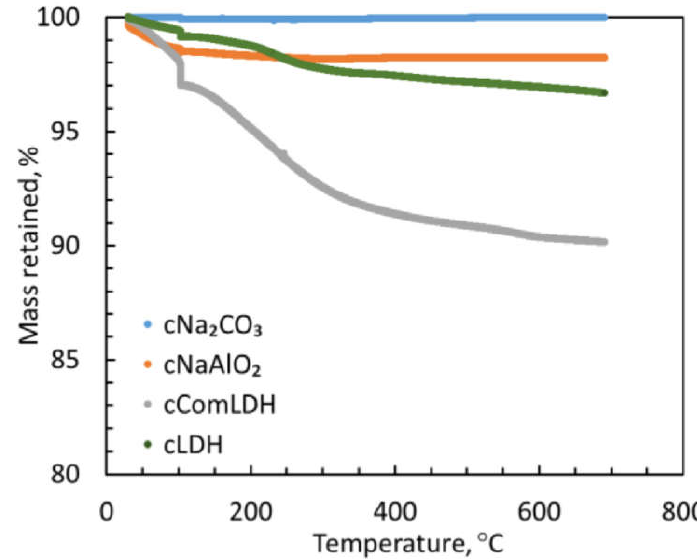
Figure 5. TGA of the calcined sorbents as a function of temperature [109].